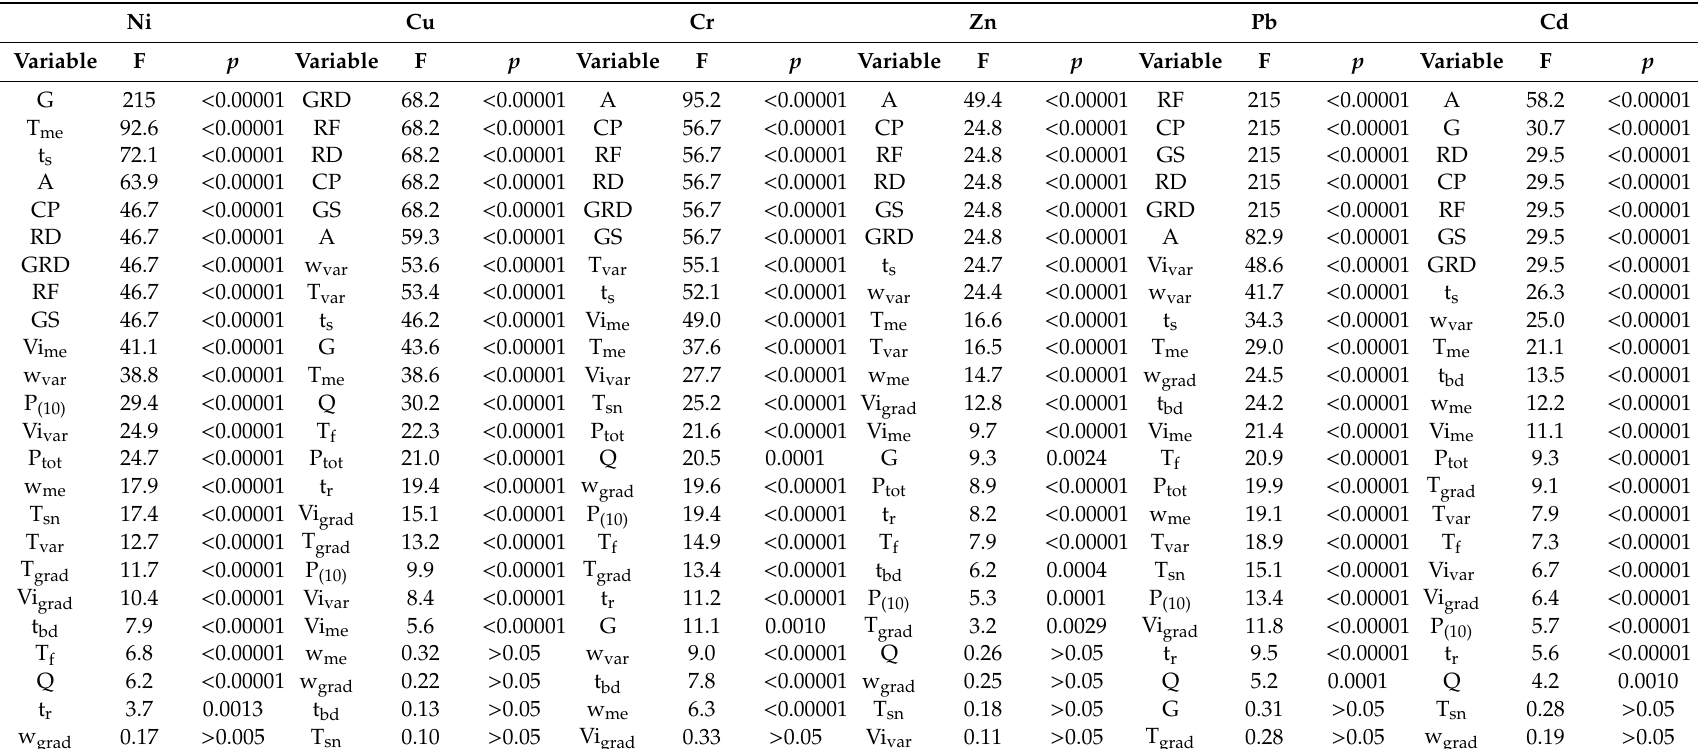
Table 4. F and p values for the Fisher–Snedecor